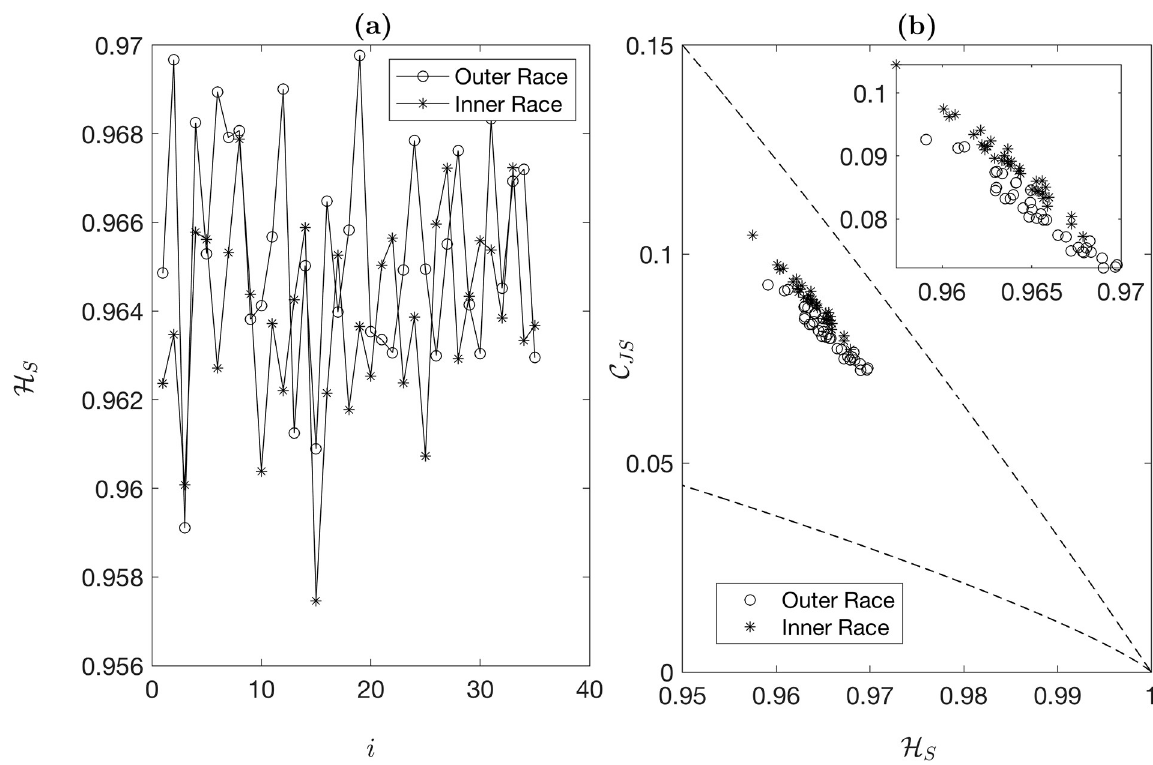
Fig 2. (a) Permutation entropy values of 35 inner race fault signals and 35 outer race fault signals, and (b) CECP values of 35 inner race fault signals and 35 outer race fault signals. The dashed lines represent the lower and upper limit curves. N = 4096, D = 6, and τ = 1. Inset figure is a scaled version of subplot